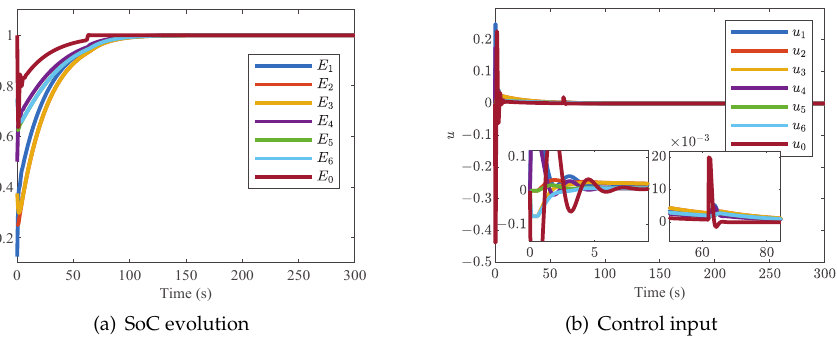
Figure 7. The SoC evolution and control input under the input time delay τ = 0.1 in the distributed charging strategy with an ME-based smart leader in Case 4.